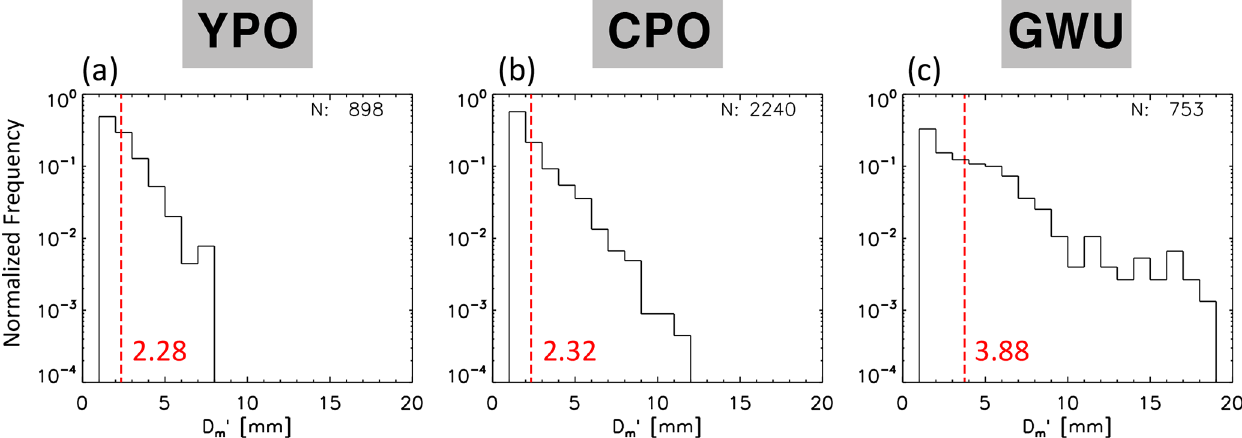
Figure 8. Normalized frequency of D (cid:48) m at (a) YPO, (b) CPO, and (c) GWU sites for air–sea interaction events during two winter seasons. The dashed red line indicates the average value for each